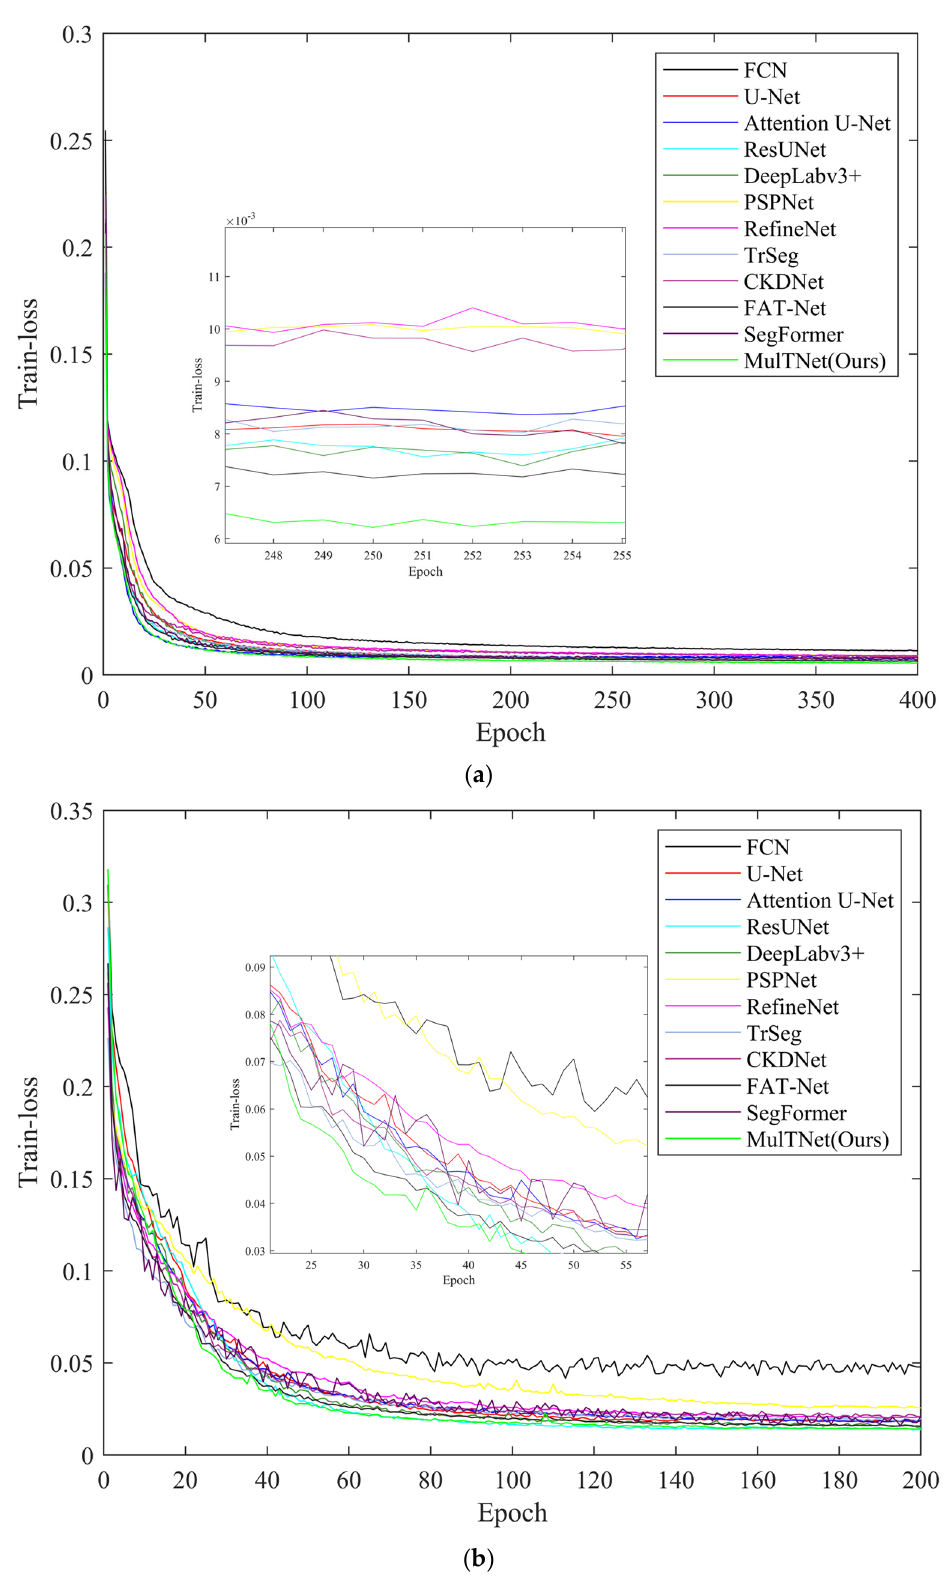
Figure 5. The training losses of various segmentation networks for two datasets: ( a ) dataset of ma- rine animals; ( b ) dataset of ISIC 2018. animals; ( b ) dataset of ISIC